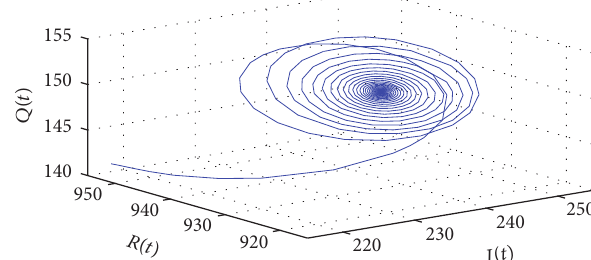
Figure 3: The projection of the phase portrait of system (69) in (𝑆,𝐸, 𝑉) -space with 𝜏 = 4.60 . 1